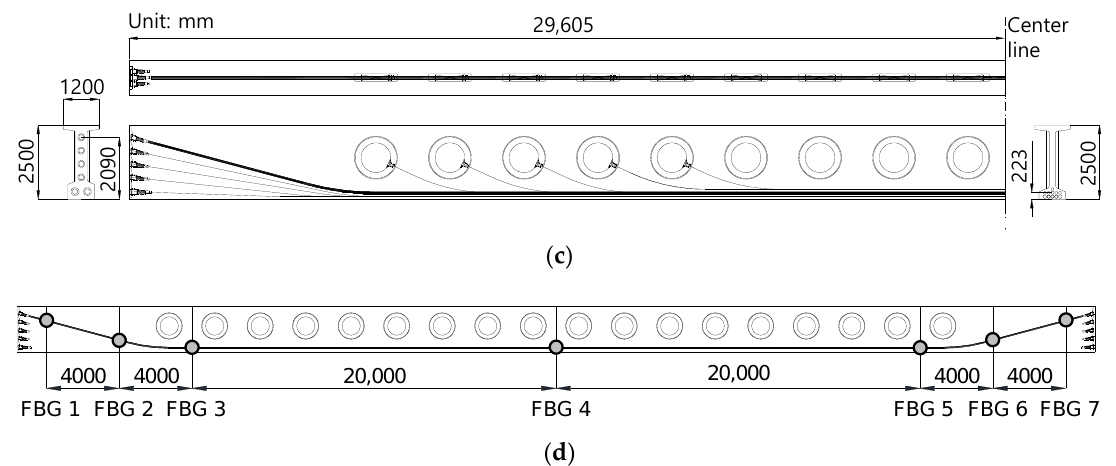
Figure 5. Prestressed concrete (PSC) girder bridge: ( a ) Tensioning of strands, ( b ) view after completion, ( c ) arrangement of tendons, and ( d ) Smart Strand with fiber Bragg gratings (FBGs).